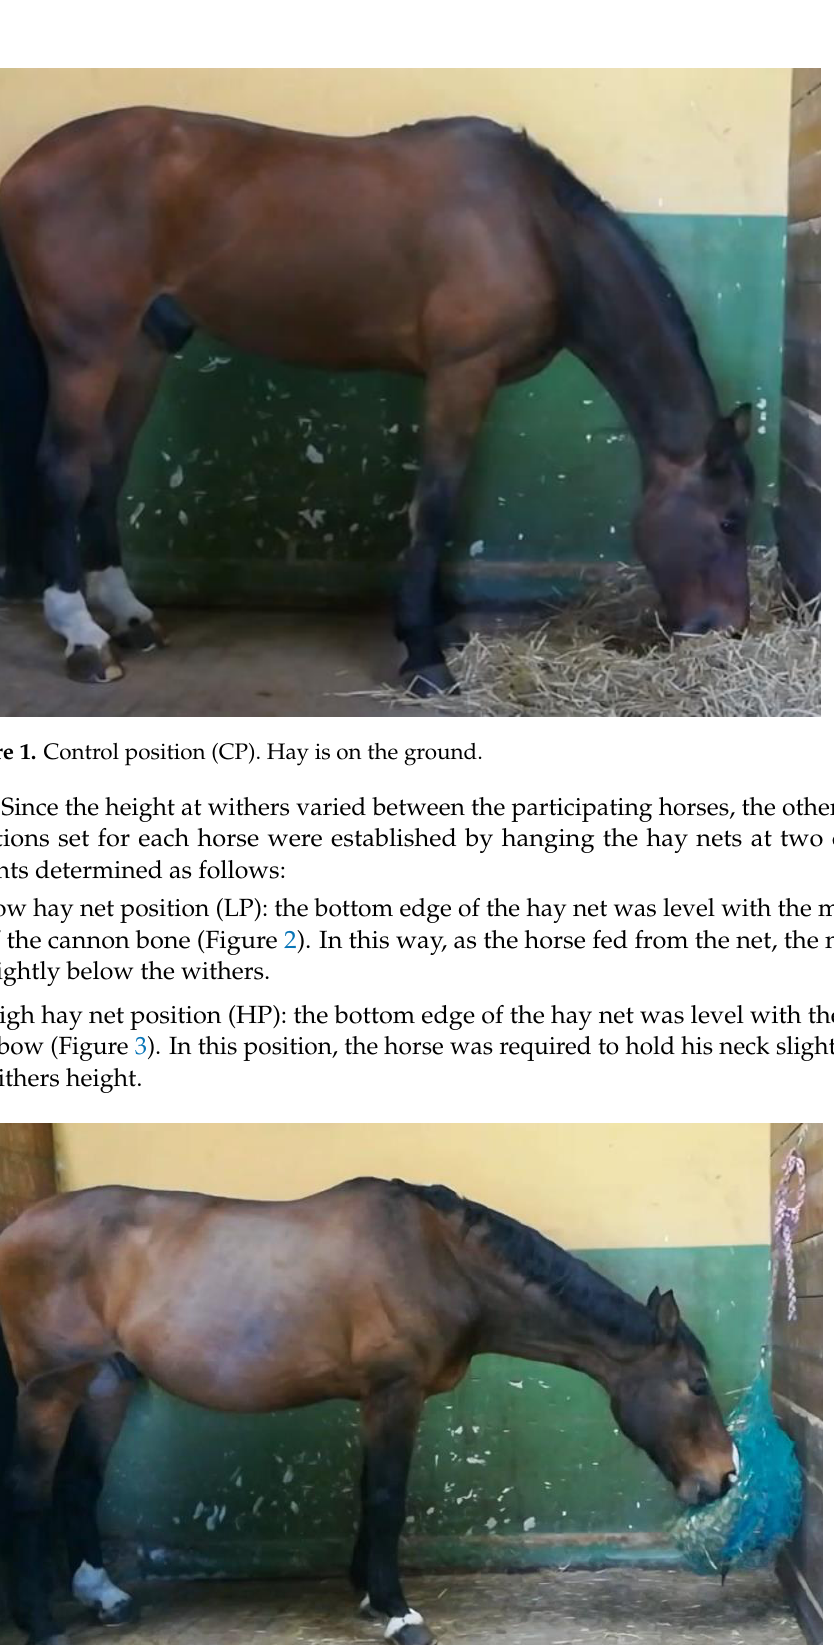
Figure 2. Low hay net position (LP). The bottom edge of the hay net is level with the mid-point of the cannon bone.